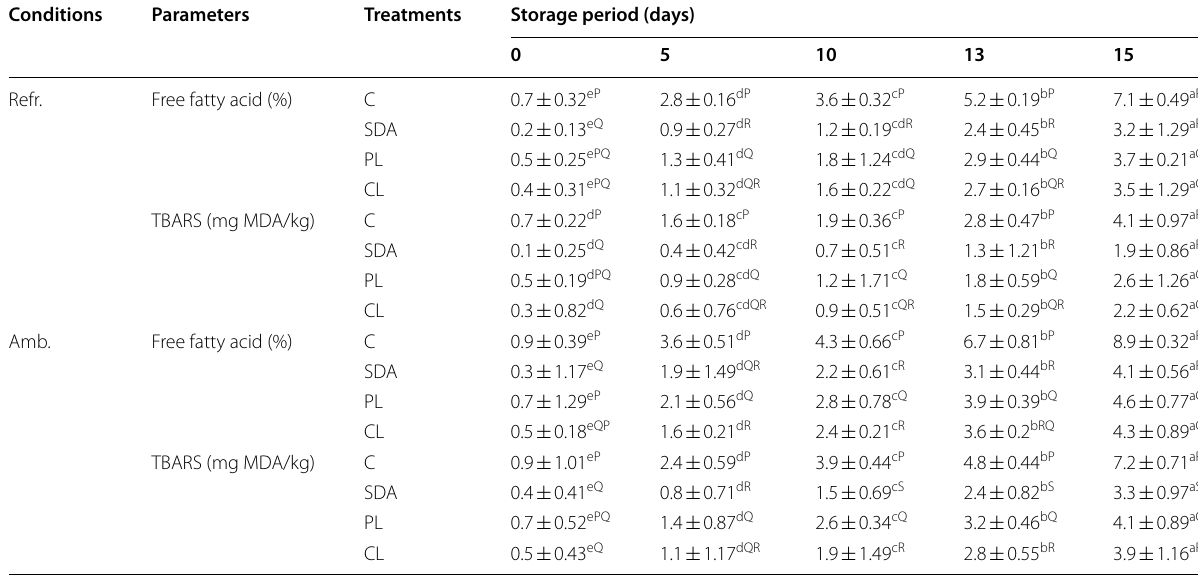
All values are mean standard deviation of three replicates ( n ± Values followed by the same letter in a row and the column do not differ significantly ( p within a column C: control; SDA: gravy treated with 0.25% sodium diacetate; PL: gravy treated with 2.5% potassium lactate; CL: gravy treated with 2.5% calcium